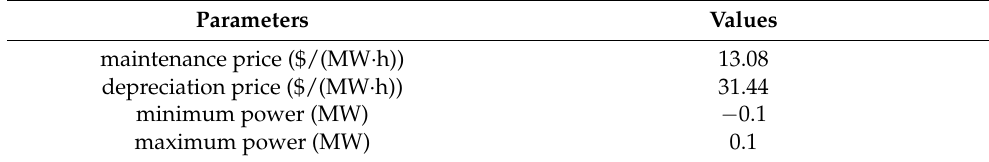
Table 2. The parameters of the battery.